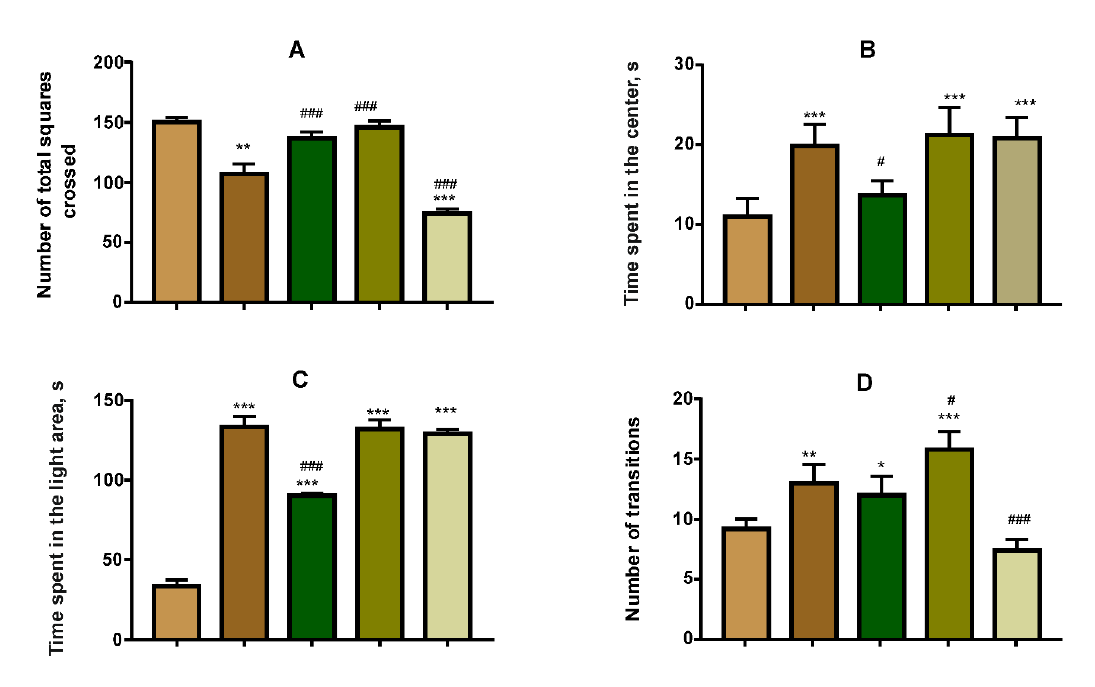
Figure 3. Effects of VBZ102, vehicle, and bromazepam on ( A ) the number of total squares crossed in the open field test, ( B ) the time spent in the center in the open field test, ( C ) the time spent in the light area in the LDB test, and ( D ) the number of transitions in the LDB test. The data are expressed as mean ± standard deviation. The analysis was done using two-way repeated-measures analysis of variance followed by the Tukey post-hoc test. *** p ≤ 0.001, ** p ≤ 0.01, * p ≤ 0.05, compared to the respective session of the vehicle group. ### p ≤ 0.001, # p ≤ 0.05, compared to the bromazepam group.